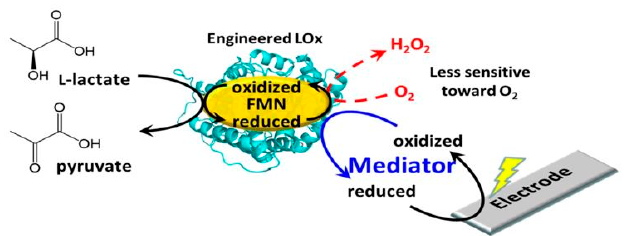
Figure 2. Enzymatic schematic of the engineered lactate oxidase (LOx). LOx oxidises l-lactate to pyruvate through the reduction of its co-factor, flavin mononucleotide (FMN). The engineered LOx, which is much less sensitive toward oxygen, utilises virtually only artificial electron acceptors to re-oxidise FMN. Reduced artificial electron acceptors can transfer the electrons between the LOx and the electrode. Figure reproduced from ref. [46]. Table 2. Summary of enzymatic sensor platforms for the detection of lactate, highlighting the enzyme, materials used, method of detection, biological medium, linear range, and limit of detection. Sensor Method of Limit of Sample Enzyme Material Detection Detection Medium LOx a Saliva SPE f /Methocel